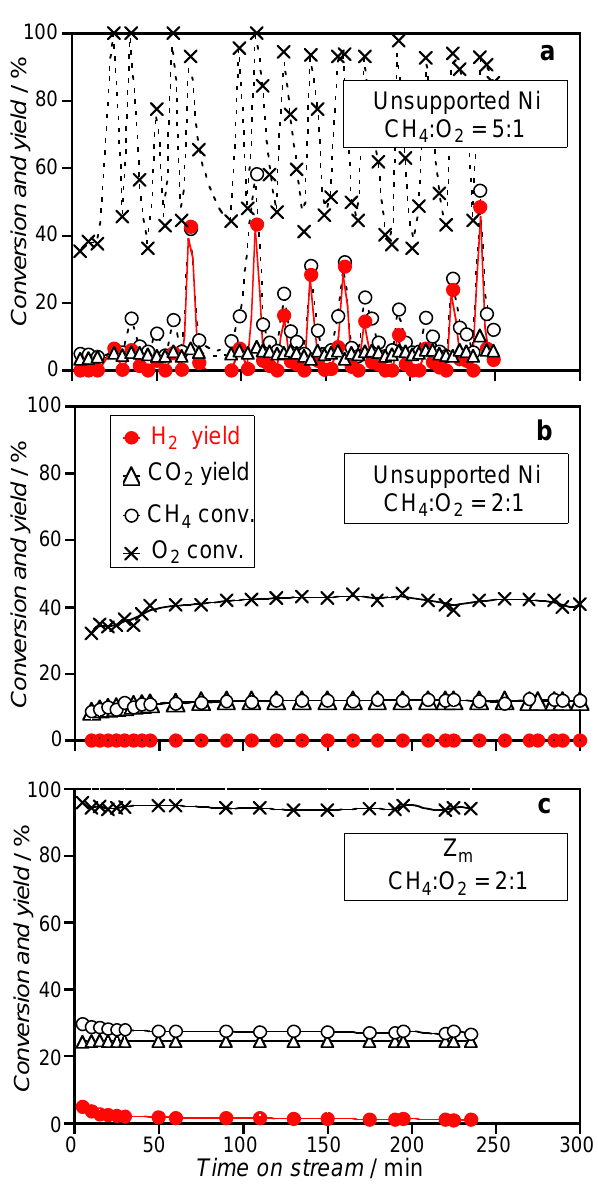
Figure 10. Catalytic activity of unsupported Ni metal and monoclinic ZrO 2 (Z m ) with reactant mixtures at different CH 4 :O 2 ratios. CH 4 and O 2 conversions and H 2 and CO 2 yields as a function of time on stream at 1023 K for ox-red -activated catalysts. ( a ): [CH 4 ] = 2%, [O 2 ] = 0.4%. ( b , c ): [CH 4 ] = 2%, [O 2 ] = 1%, N 2 as balance; total flow rate = 150 cm 3 (STP) · min − 1 . All the Ni/Z m ( ox-red ) and Ni/Z hy ( ox-red ) catalysts were highly active (Figures 11a–d and 12a,b) and selective (Figure 12c,d) for the CH 4 -CPO at 1023 K with the CH 4 :O 2 = 2:1 mixture. The most active 4.8Ni/Z hy ( ox-red ) sample reached, at 1023 K, a CH 4 conversion and H 2 selectivity close to the equilibrium (90% and 95%, respectively [14], Figure 11d and